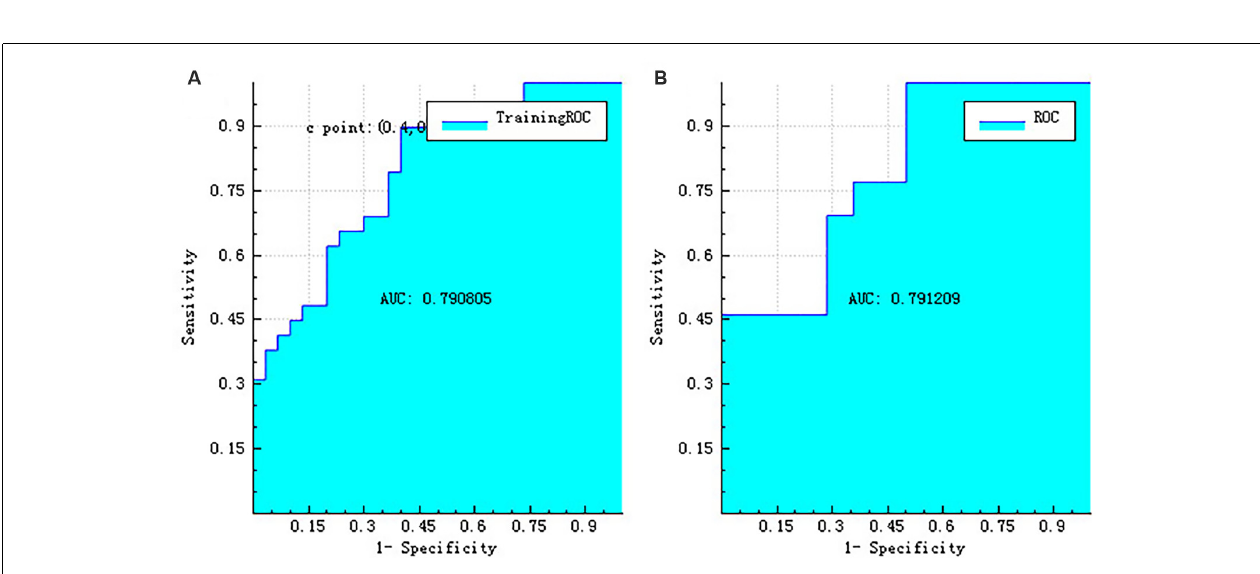
FIGURE 8 | The ROC curve of training data (A) and the ROC curve of testing data (B) of the left hippocampus. ROC, receiver operating